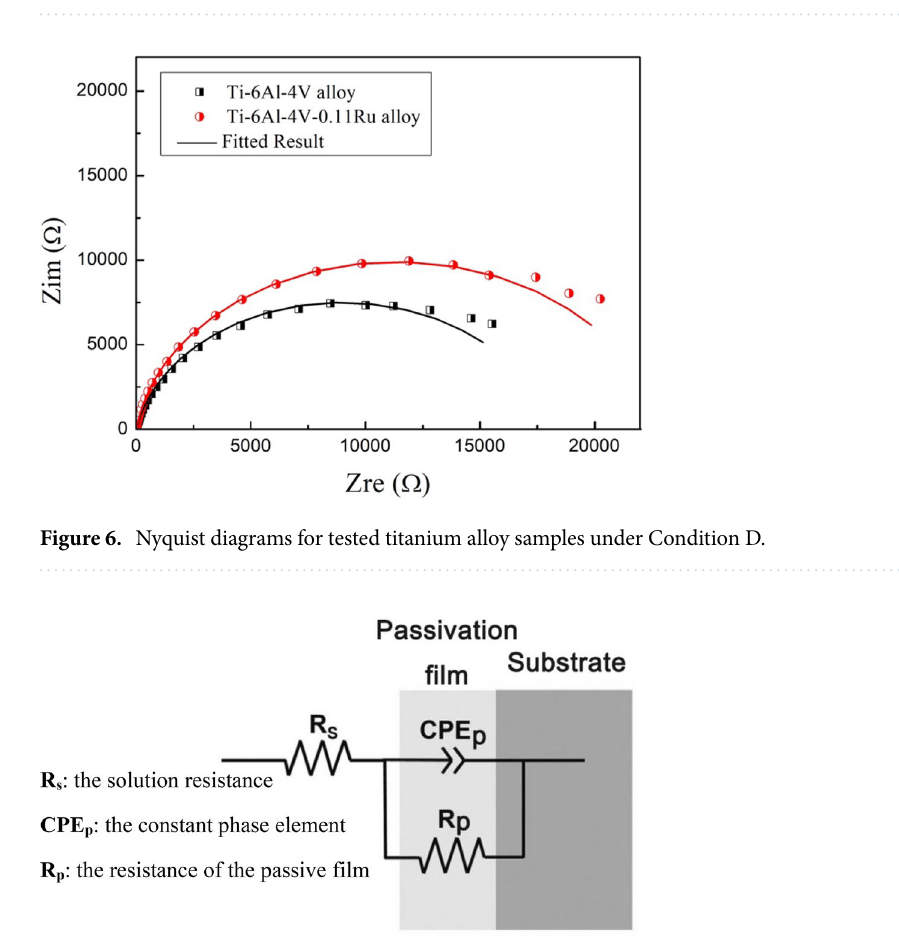
Figure 7. Equivalent electrical circuit model used for impedance spectra analysis of titanium